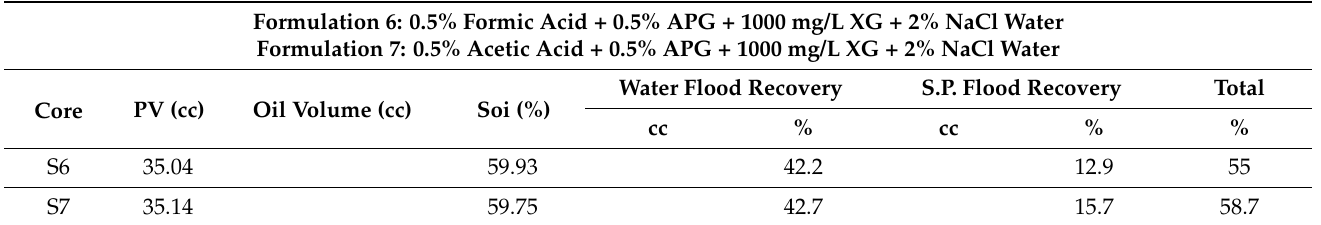
Table 11. Flood results for acrylic acid, APG 264, and Xanthan gum